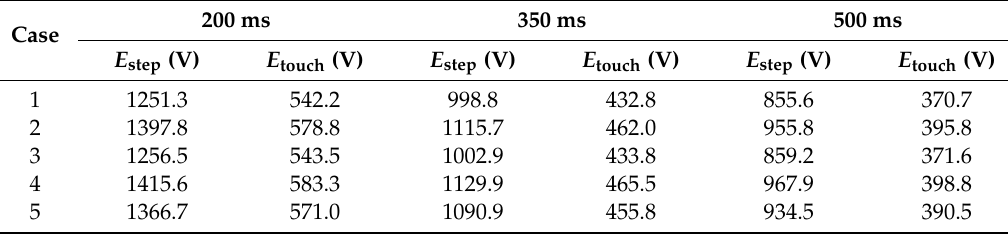
Table 4. Maximum permissible limits for step and touch voltages from the two-layer soil model. Case